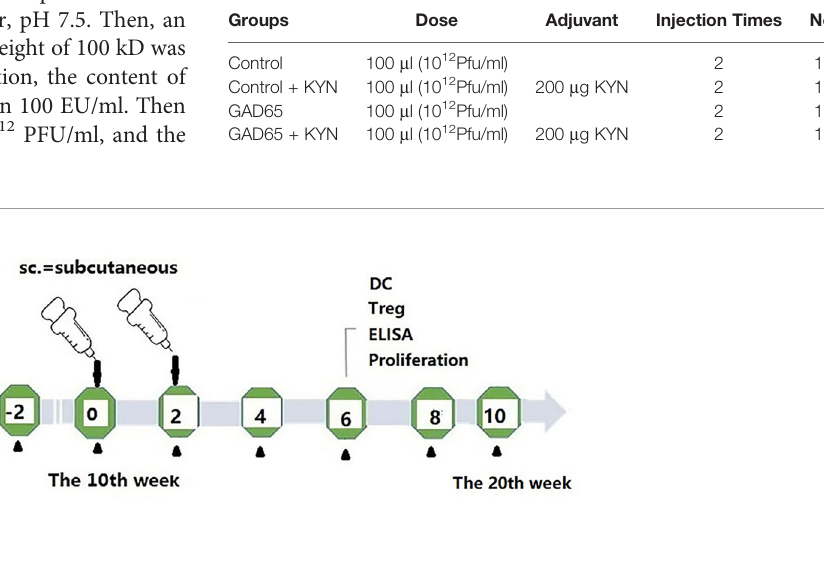
FIGURE 1 | Schematic Map of immunization schedule.